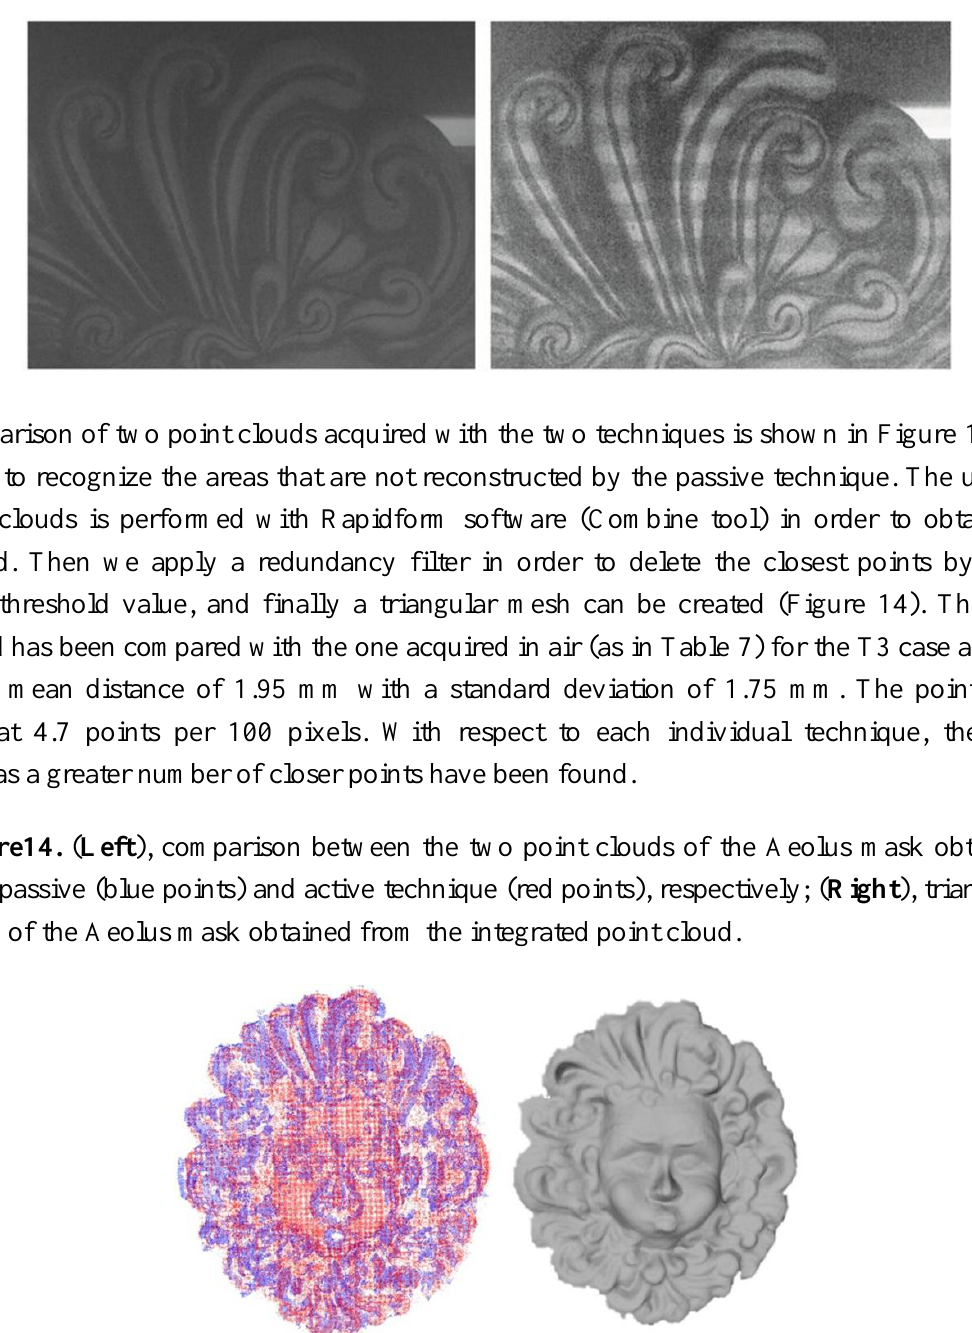
Figure 13. Dark and homogeneous areas present in the Aeolus image ( Left ) are better detected using structured light ( Right ), in the presence of turbidity.